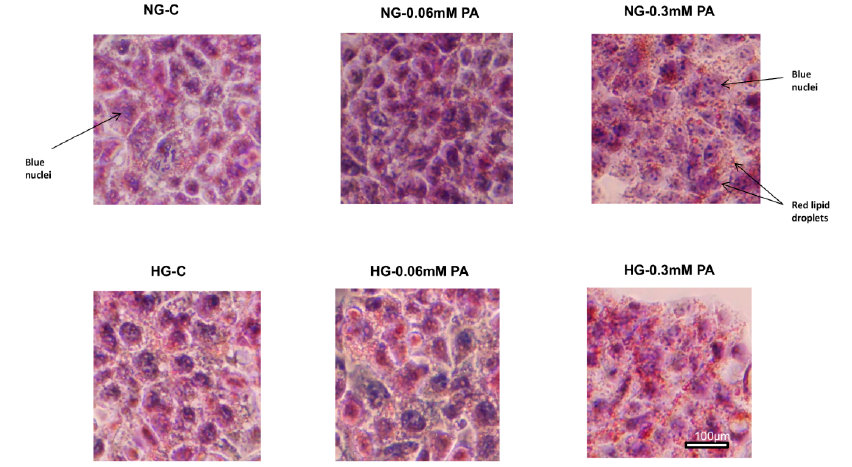
Figure 11. Effect of high glucose/high palmitic acid (HG/HPA) on lipid accumulation. HepG2 cells were grown on coverslips, treated with different doses of palmitic acid under normal and high glucose conditions, and stained with Oil Red O dye, as described in the Materials and Methods section. Hematoxylin was used for nuclear staining and viewed using the EVOS XL Core Imaging system (40× magnification). Lipid droplets appear red and nuclei appear blue.